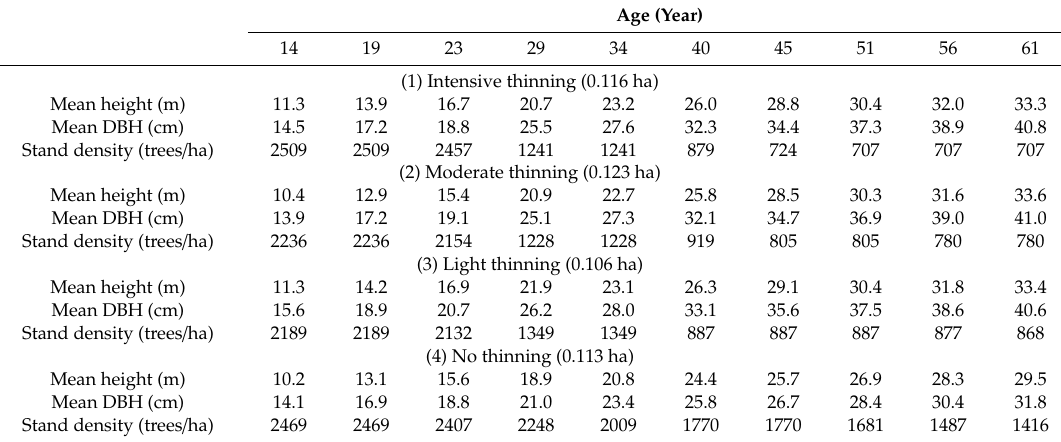
Table 2. Summary of measurement data in study